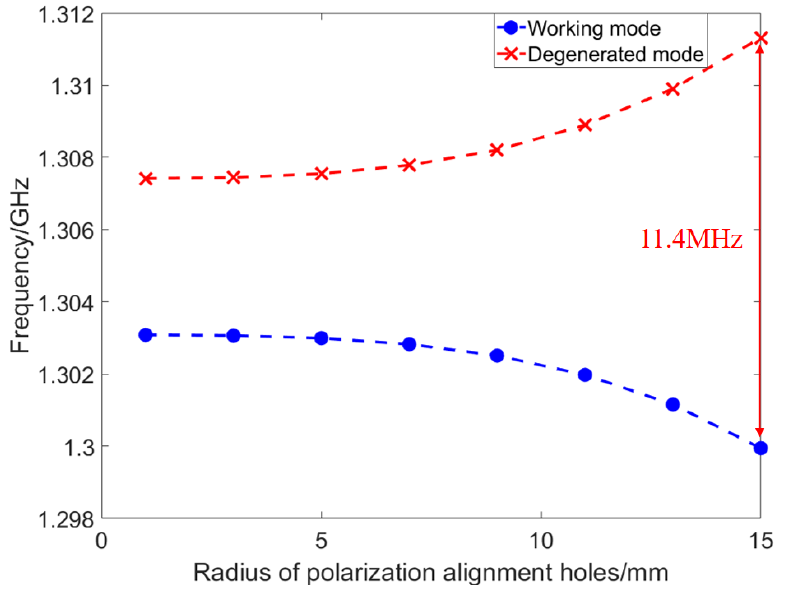
Figure 4. The influence of the polarization alignment holes radius on the mode frequency separation. The final parameters of the deflecting cavity are shown in Table